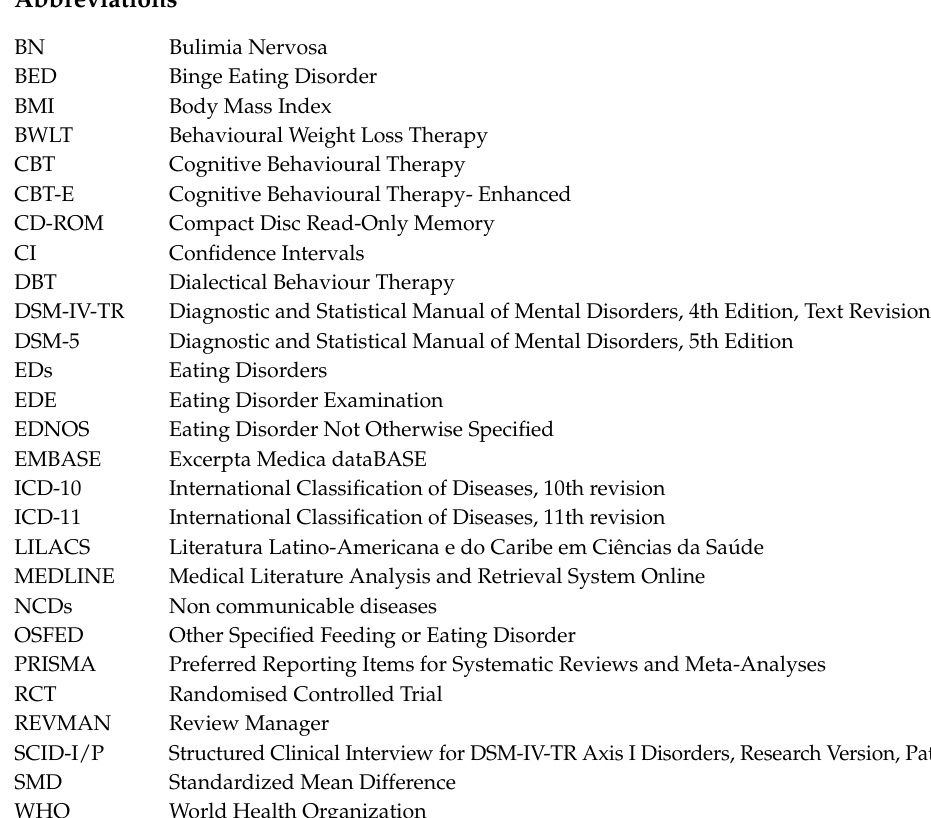
Table S1: Trials excluded from the review with reasons for exclusion, Figures S1: Forest plot of additional meta-analysis: Mean BAO at end of treatment, Figure S2: Forest plot of additional meta-analysis: Mean binge frequency at 12 months follow-up, Figure S3: Forest plot of additional meta-analysis: Mean BMI at 12 months follow-up, Figure S4: Forest plot of additional meta-analysis: Treatment completion rates at end treatment, Figure S5: Forest plot of additional meta-analysis: Treatment completion rates at end